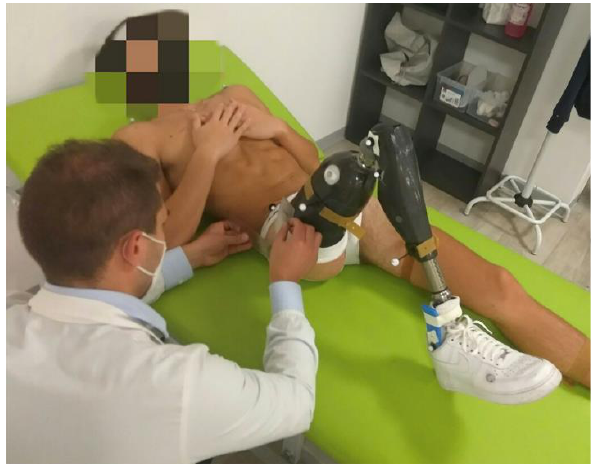
Figure 3: Measurement of hip flexion of the prosthetic